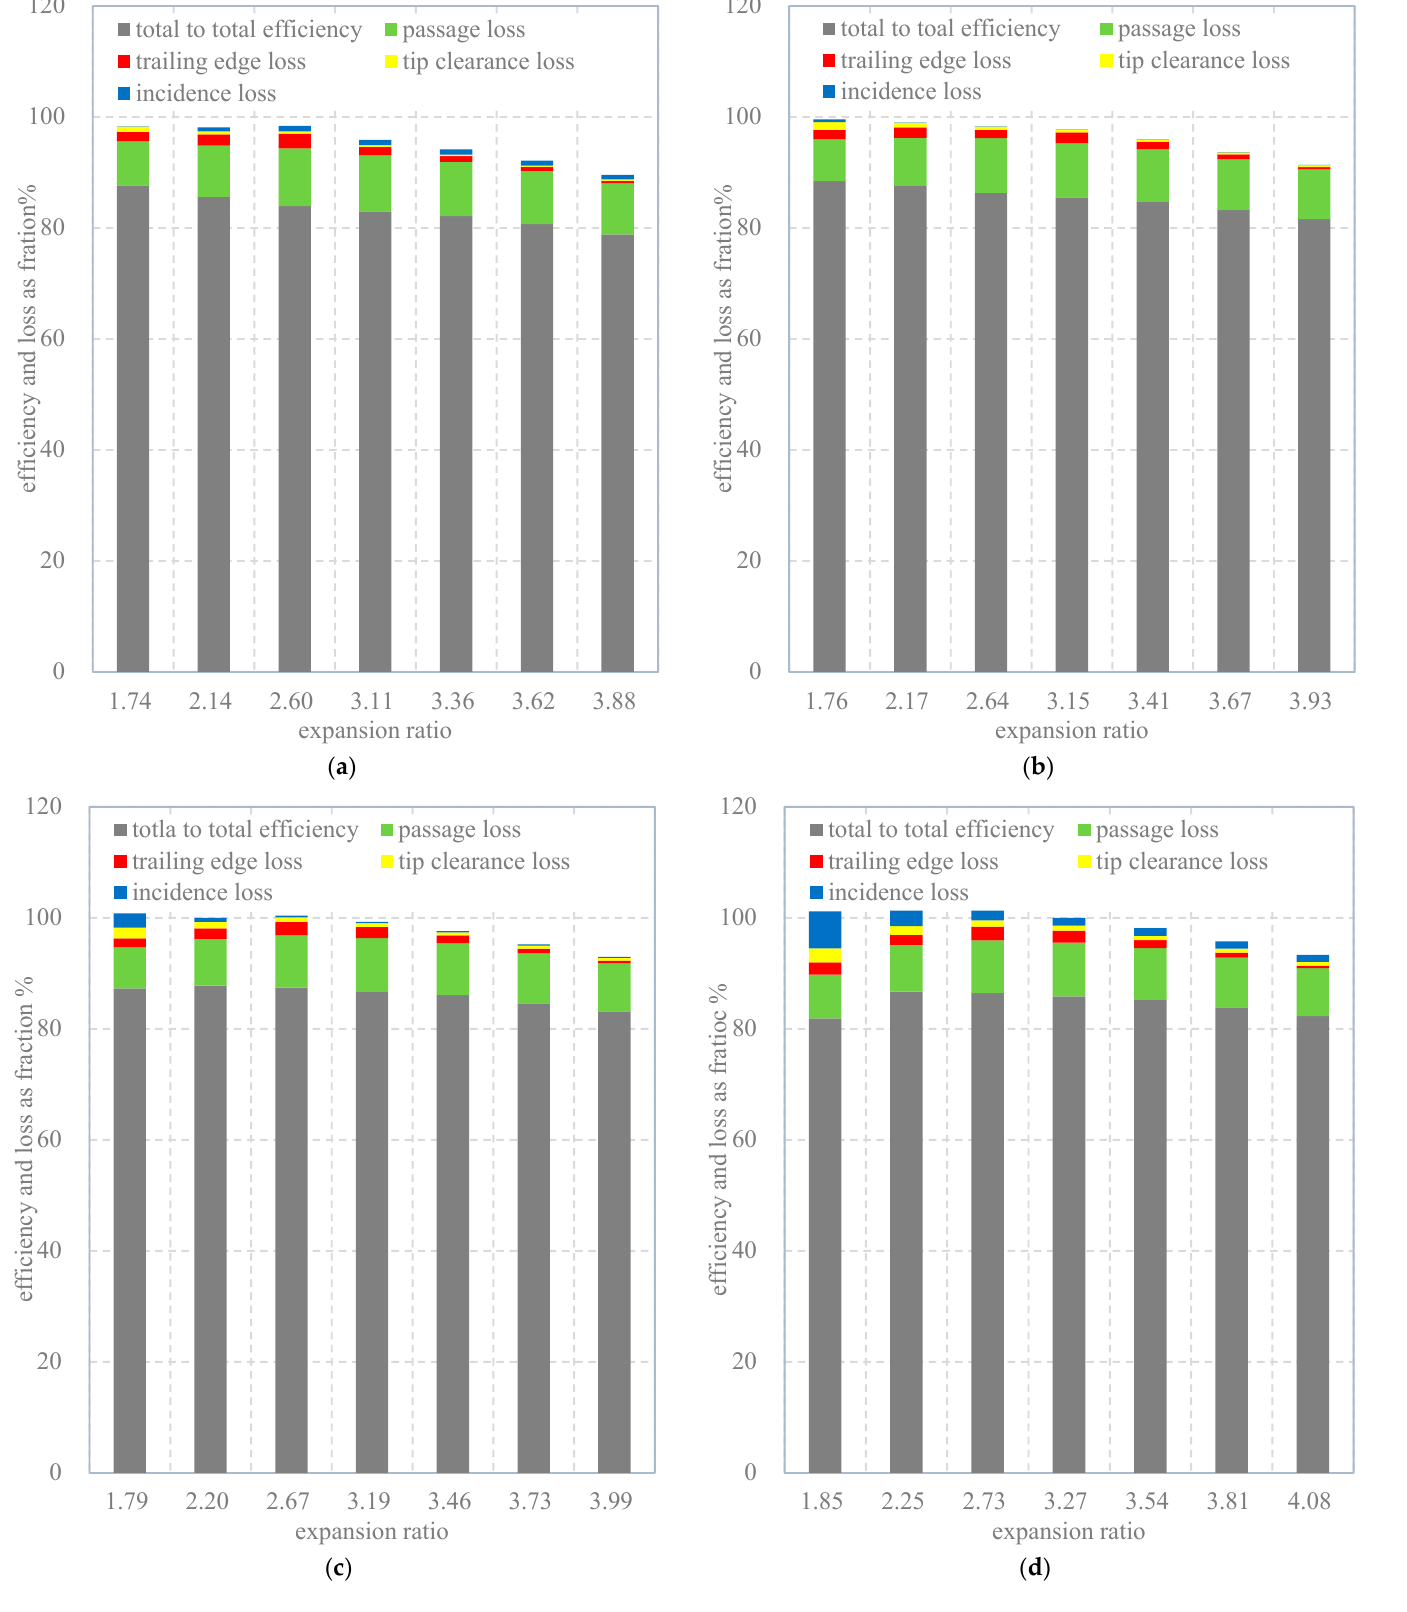
Figure 9. The distribution of efficiency and the percentage of four traditional losses. ( a ) 70,000 rpm.